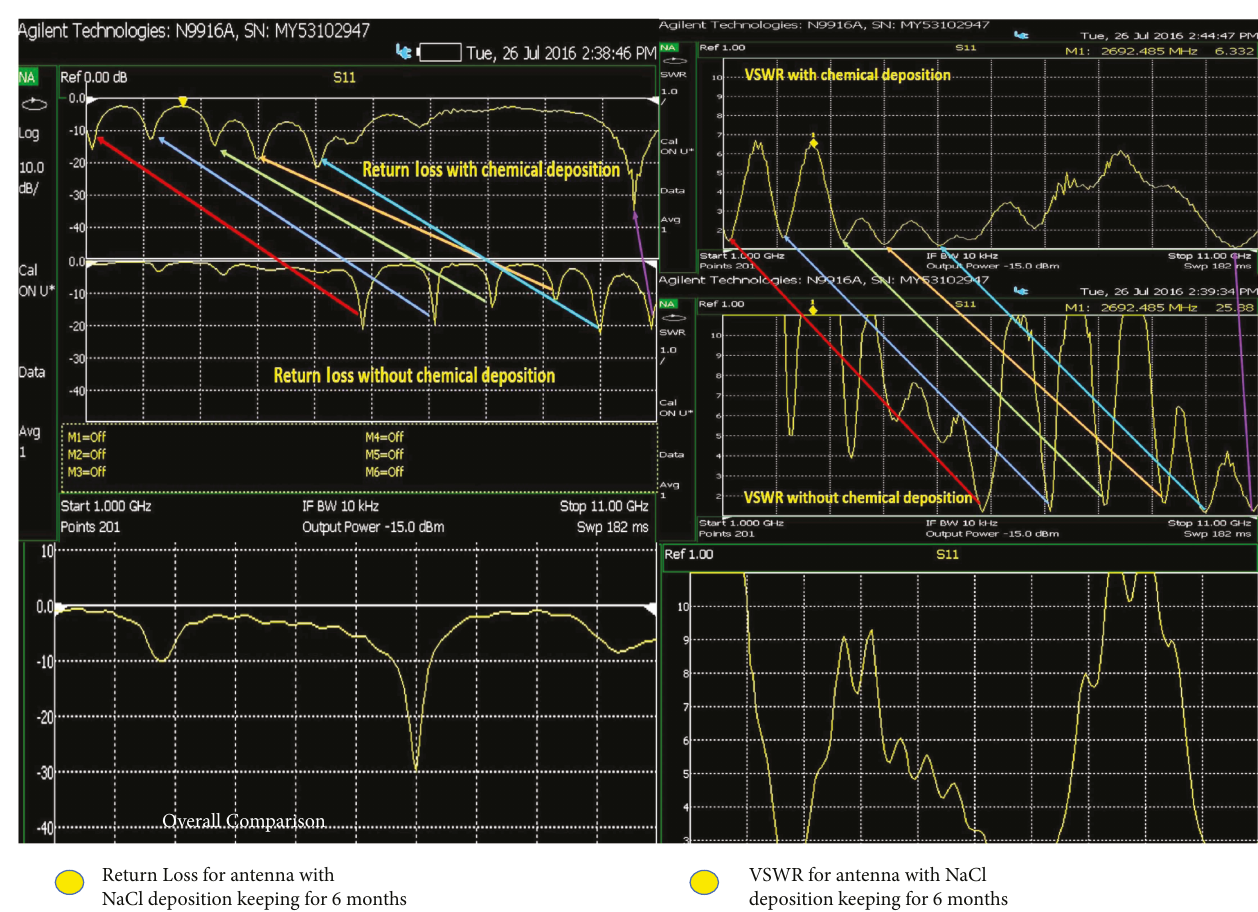
Figure 7: Experimental result for the antenna with, without NaCl deposition, and with deposition for 6